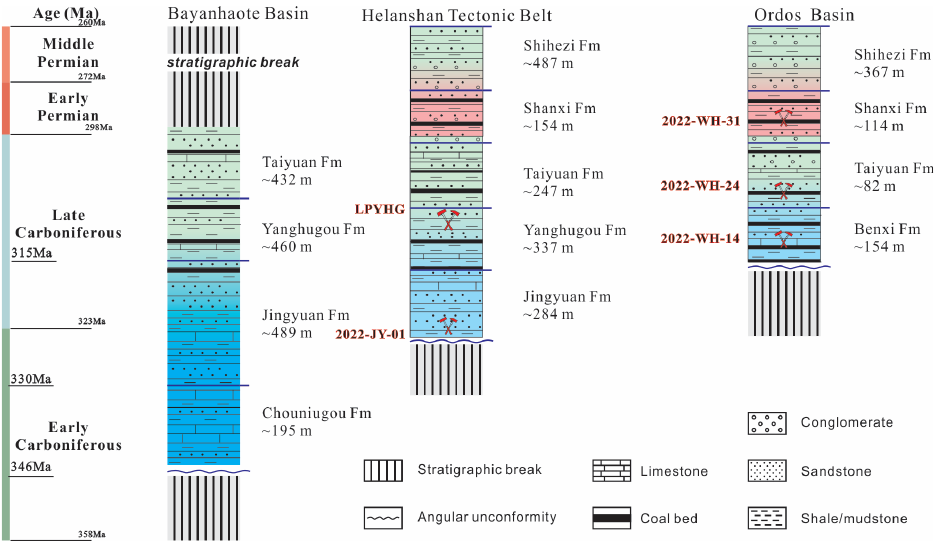
Figure 3. Stratigraphic sequence and lithologic assemblages of Carboniferous to Permian successions in the Bayanhaote Basin, Helanshan Tectonic Belt, and the Ordos Basin (modified from Sun and Dong [2]).